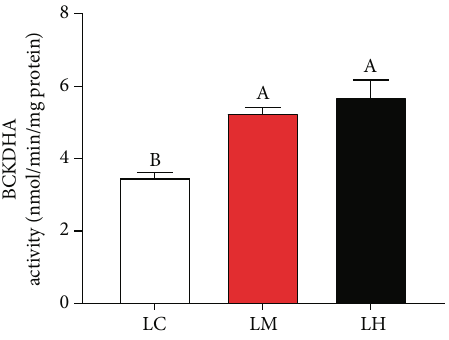
Figure 7: The activity of BCKDH in blunt snout bream muscle cells cultured in the three medium of leucine levels. Values are represented as mean ± SEM ( n = 4 ) by vertical bars. Mean values with di ff erent letters indicate signi fi cantly di ff erent ( P < 0 : 05 ).